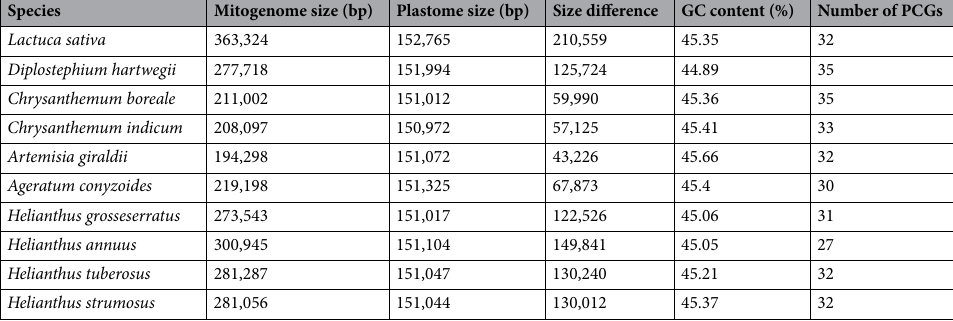
Table 2. Comparison of mitogenome and plastome in terms of size, GC content and number of PCGs in 10 Asteraceae plants.